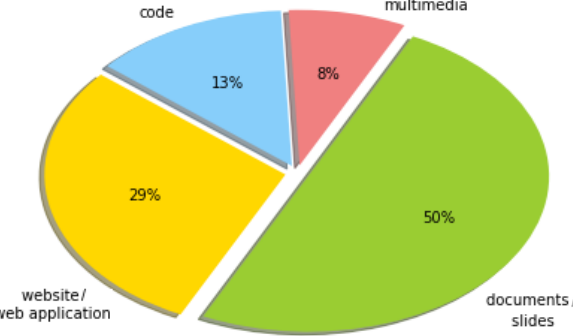
Figure 4. Types of educational material reported by the respondents to the second survey